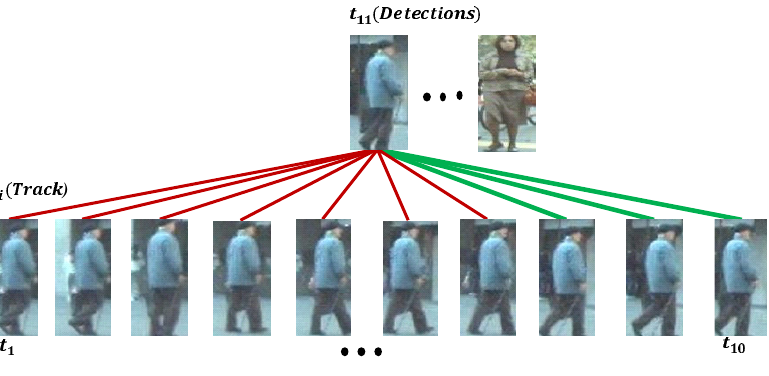
Figure 2. In long-term appearance matching, the comparison is conducted between ( t ) , ( t ) ,..., ( t ) at the time of track append. The edges show the comparison be- 11 , t 1 11 , t 2 11 , t 10 tween detected features and tracks. The red-colored edges are history features, and the green-colored edges are the recent features, respectively. The features of tracked and detected objects are extracted using a